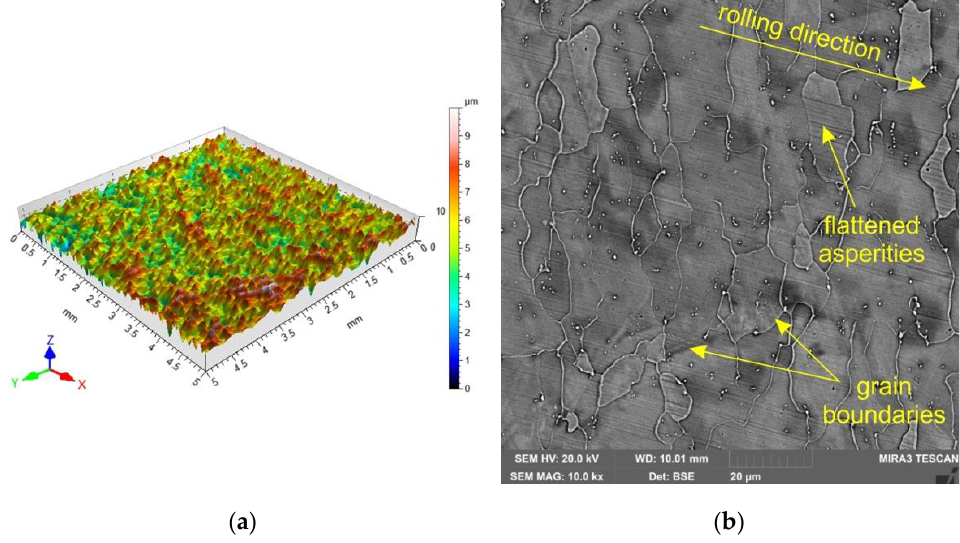
Figure 3. ( a ) Topography of the DC04 sheet and ( b ) SEM micrograph of the in the as-received state.